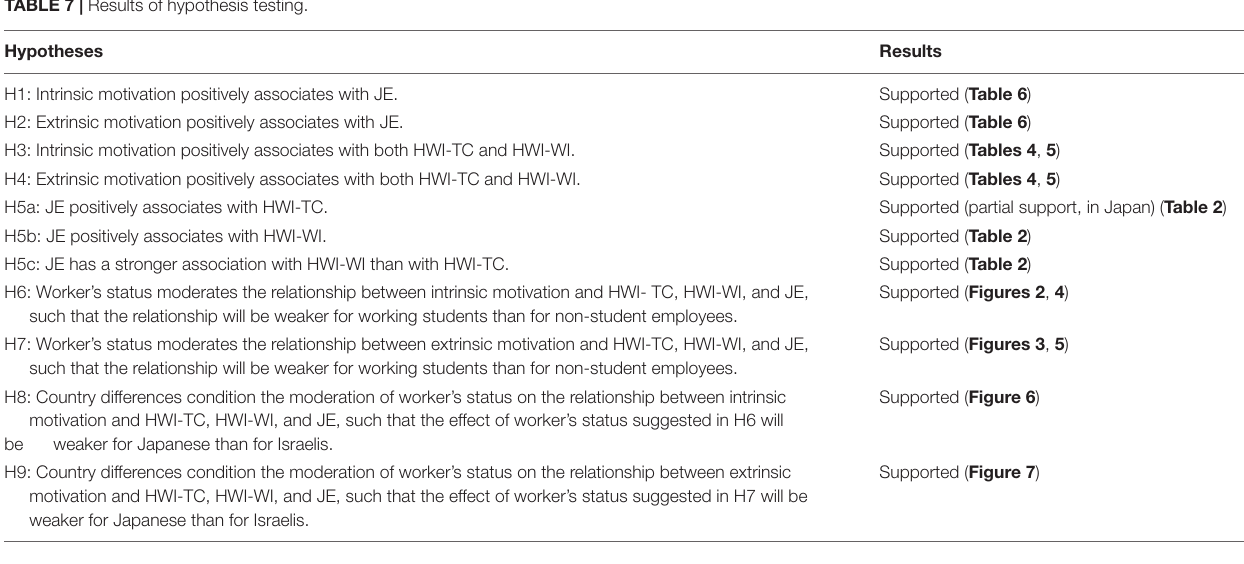
FIGURE 7 | Interaction effects of Extrinsic Motivation × Worker’s Status × Country in predicting job engagement. TABLE 7 | Results of hypothesis